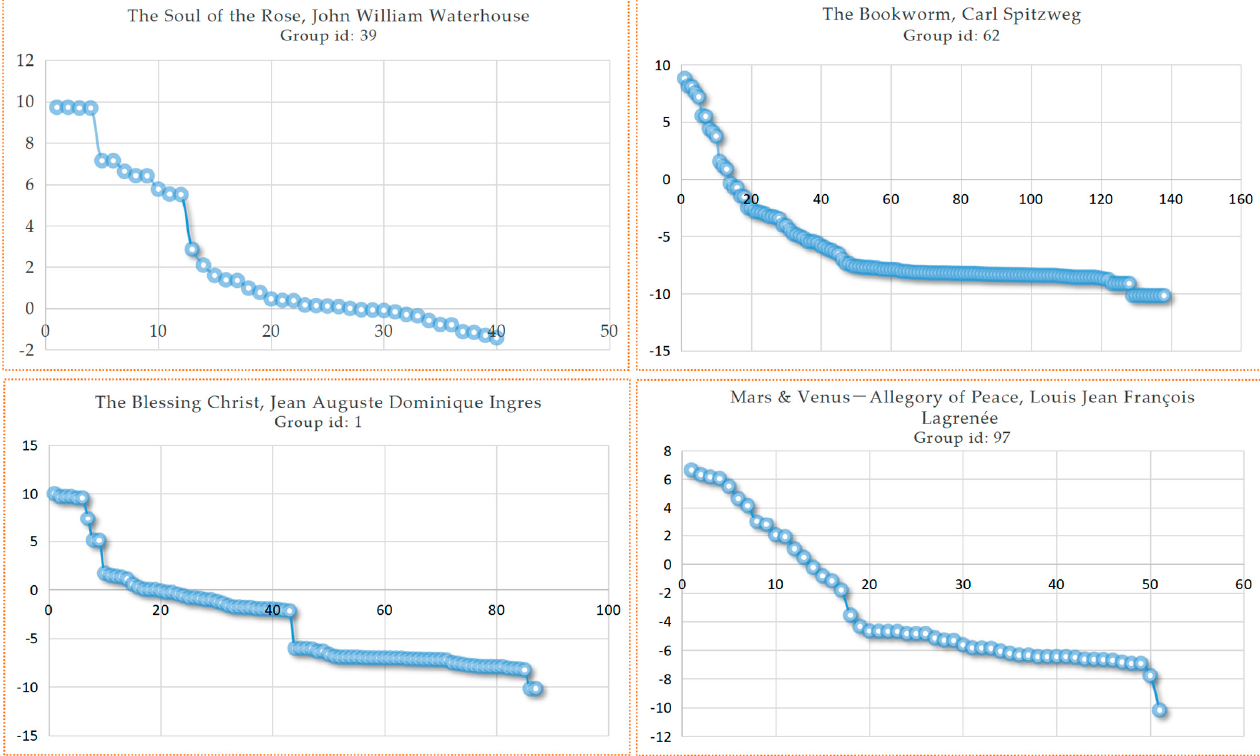
Figure 3. Distribution of the predicted ranking score for the 4 common artworks (museum posts).